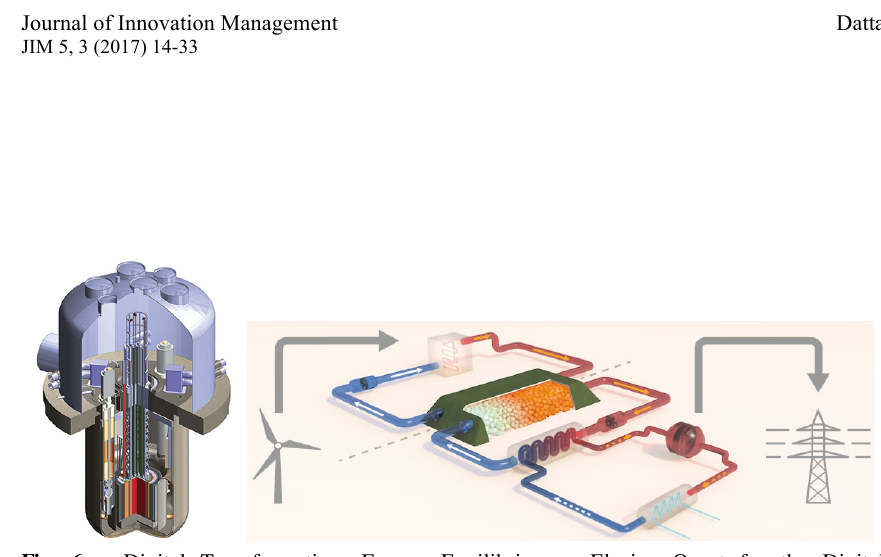
Fig. 6 – Digital Transformation: Energy Equilibrium – Elusive Quest for the Digital Mitochondria? To maintain homeostasis of energy production, distribution and load balancing. Adapting to multiple sources and types of energy obtained from diverse producers (domestic, commercial) with variable end points (homes, roadside charger, factories, mobile delivery). (illustrations extracted from: left image from [ 7 ], right image from [ 8 ])